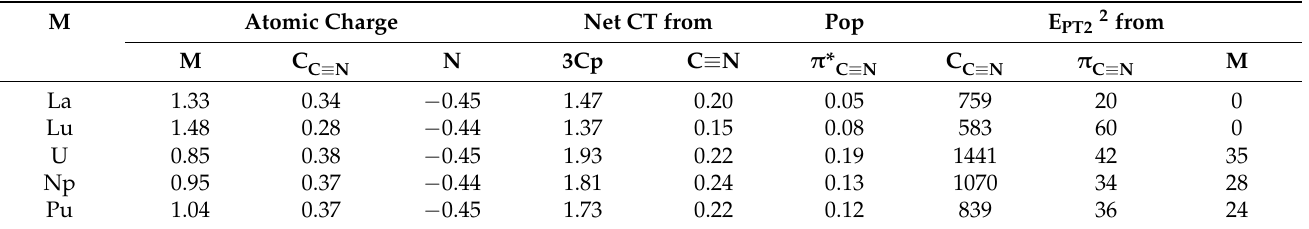
Table 3. Selected result from the NBO analysis of (Cp) 3 M(C ≡ NCy) complexes 1 .